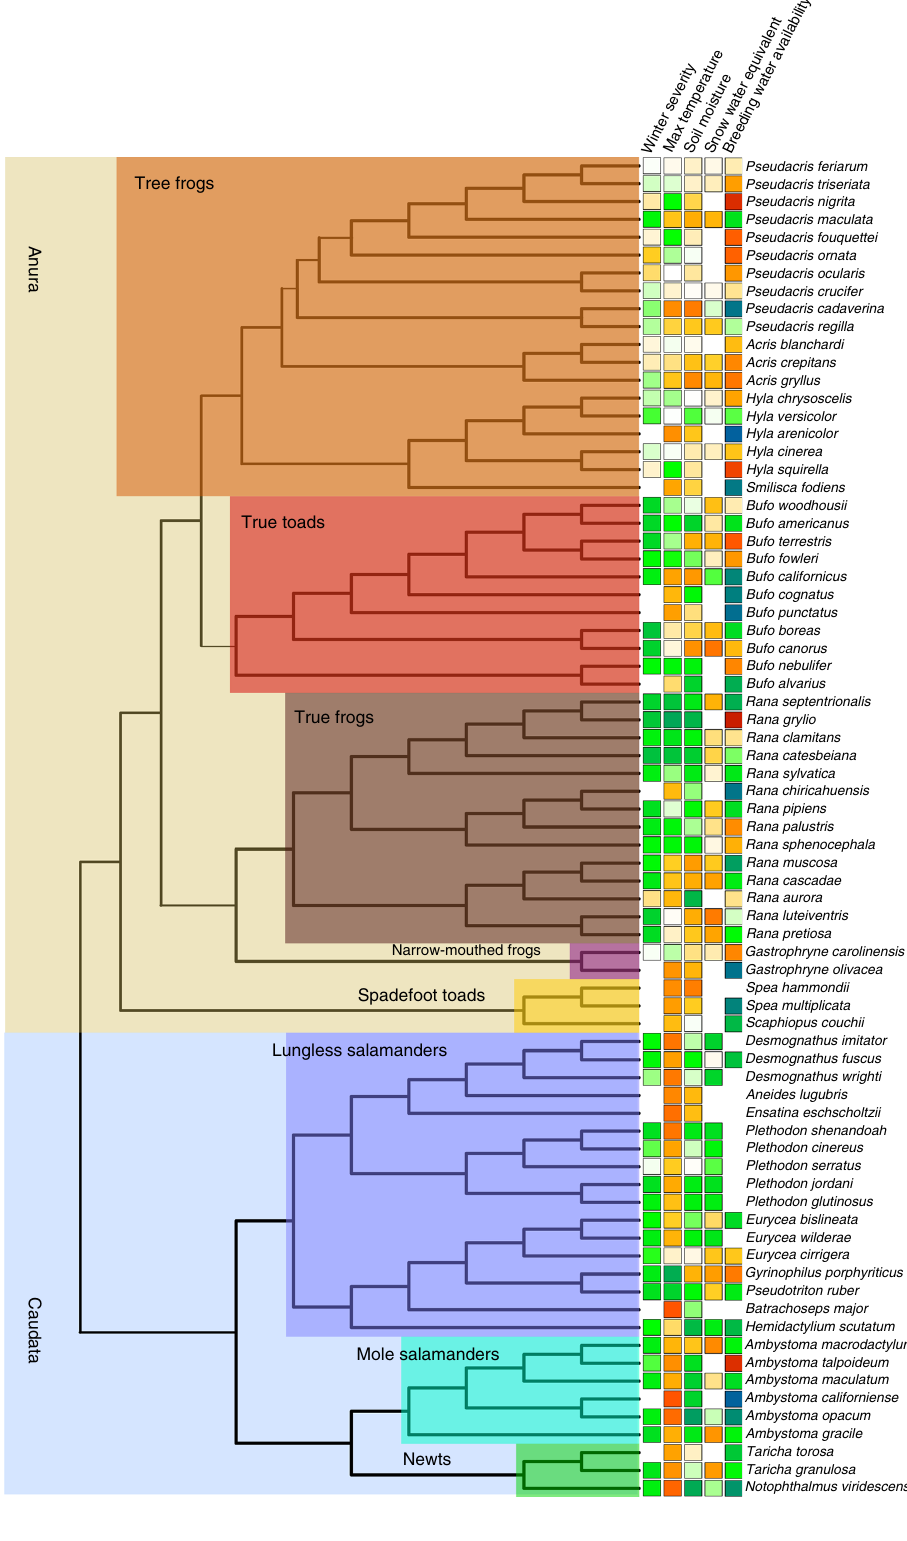
detection. Again, by relying on repeated visits to account for different detection probabilities among species, study areas, and survey methods we were able to estimate occupancy states for all locations in the